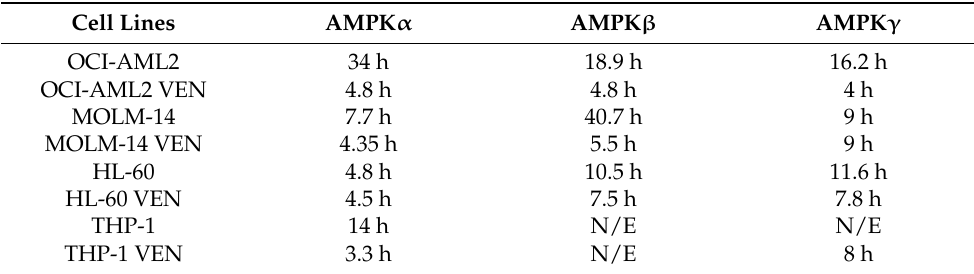
Figure 2. Decreased amount of AMPK subunits by venetoclax in AML . ( A ) Western blots were done from in vitro kinase assay protein mix using anti-phospho-ACC S79 and anti-phospho-AMPK T172 antibodies. ( B , C ) AML cell lines were incubated without or with 100 nM venetoclax (VEN), and then submitted to a cycloheximide pulse during the indicated times. ( B ) Western blots were done using anti-AMPK α , β , γ , -Bcl-2, and - β -actin antibodies. ( C ) Quantification of the Western blot signals from three independent experiments using ImaJ software for AMPK α detection in the control (CTR) or venetoclax (VEN) conditions. Table 1. Quantification of AMPK subunits half-life. Cells were submitted to a cycloheximide chase, and then AMPK subunits amount was assessed by Western blot and quantified using ImaJ. Protein half-life was calculated using the regression function of AMPK subunit detection dependent on time. N/E: not